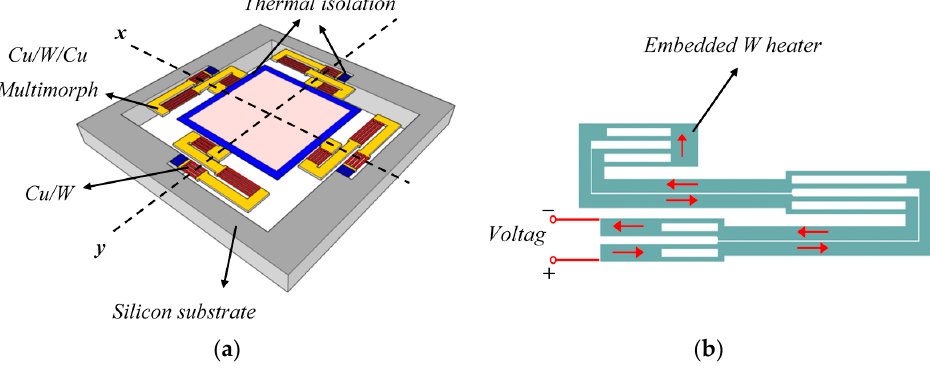
Figure 3. Schematic of ( a ) the MEMS mirror based on Cu/W LSF actuator and ( b ) the embedded W heater. W